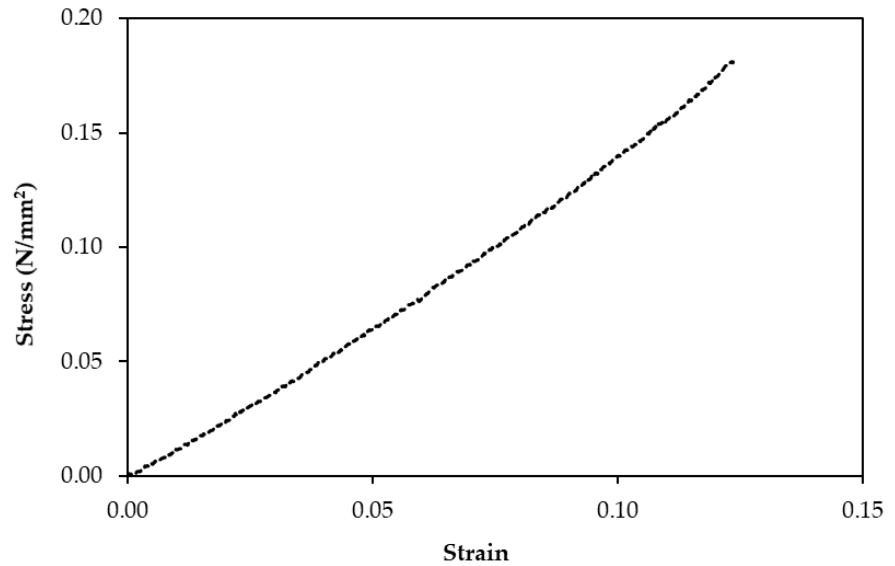
Figure 11. Representative stress-strain curve from the compression test of the natural rubber foam.